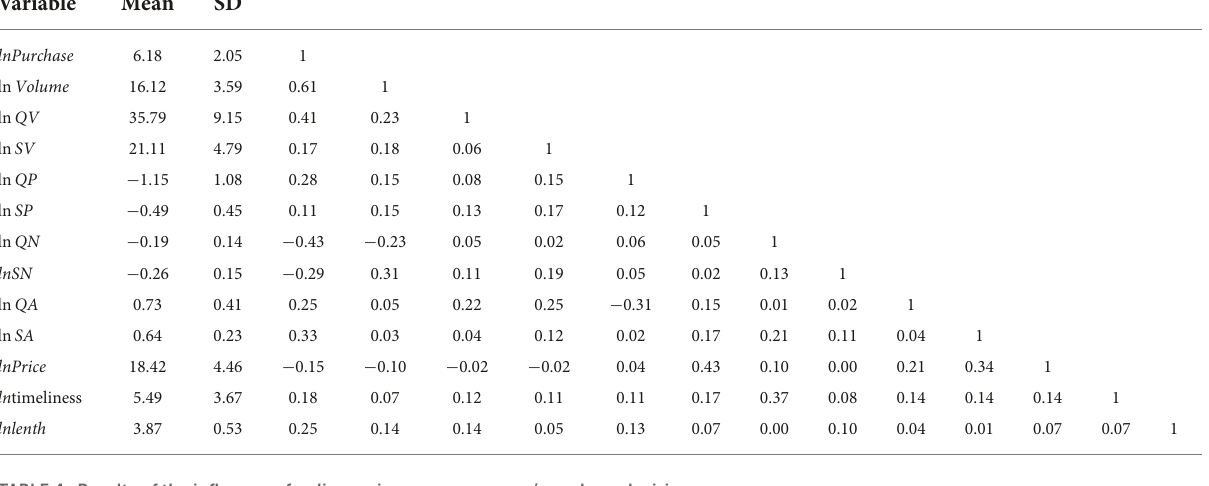
TABLE 4 Results of the influence of online reviews on consumers’ purchase